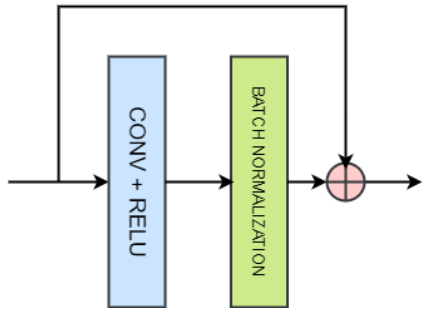
Figure 1. Proposed Residual Learning Block.